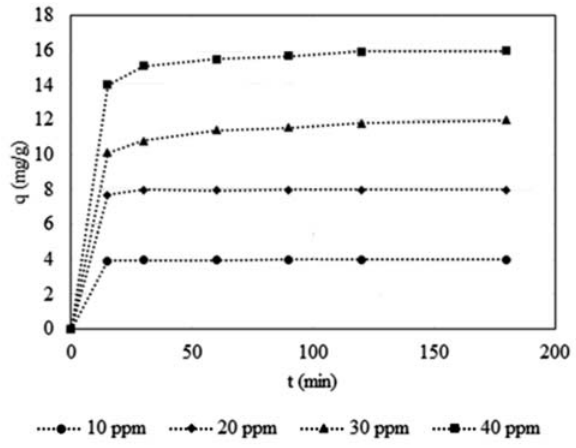
Fig. 3: Removal of Cr(III) depending on contact time